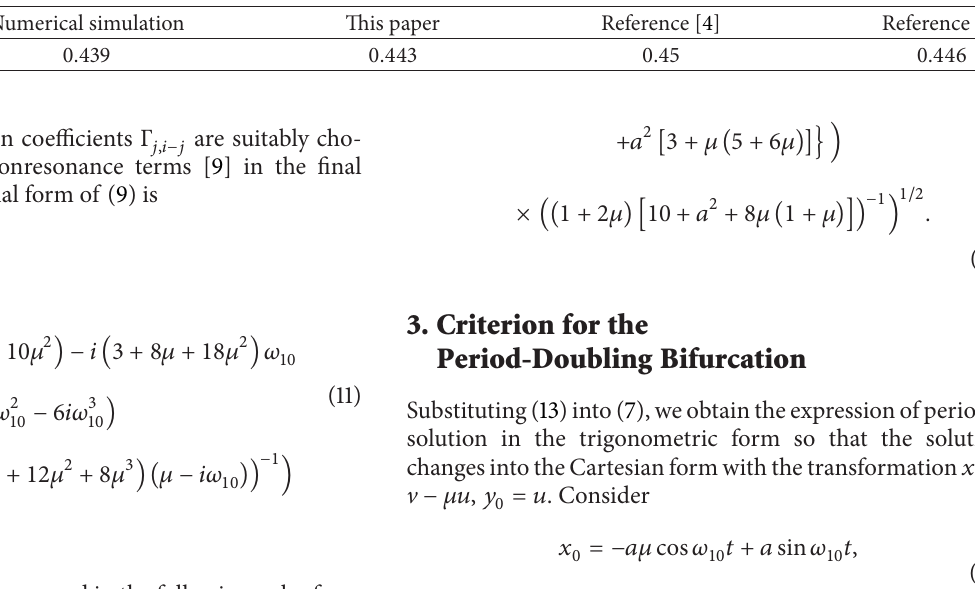
Table 1: Critical value for the first period-doubling